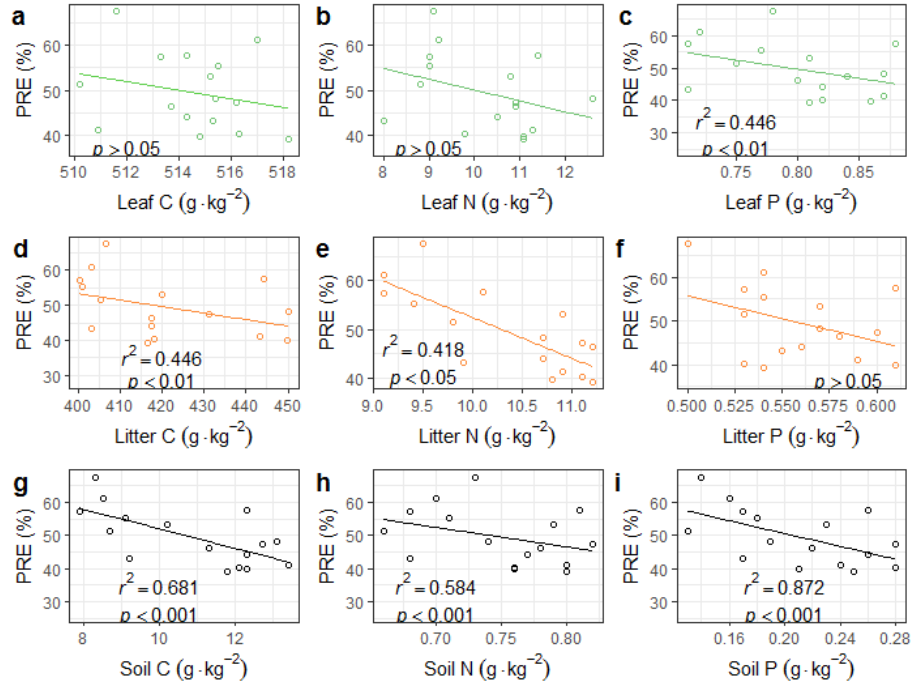
Figure A3. Relationships between PRE (P resorption efficiency) and leaf ( a – c ), litter ( d – f ), and